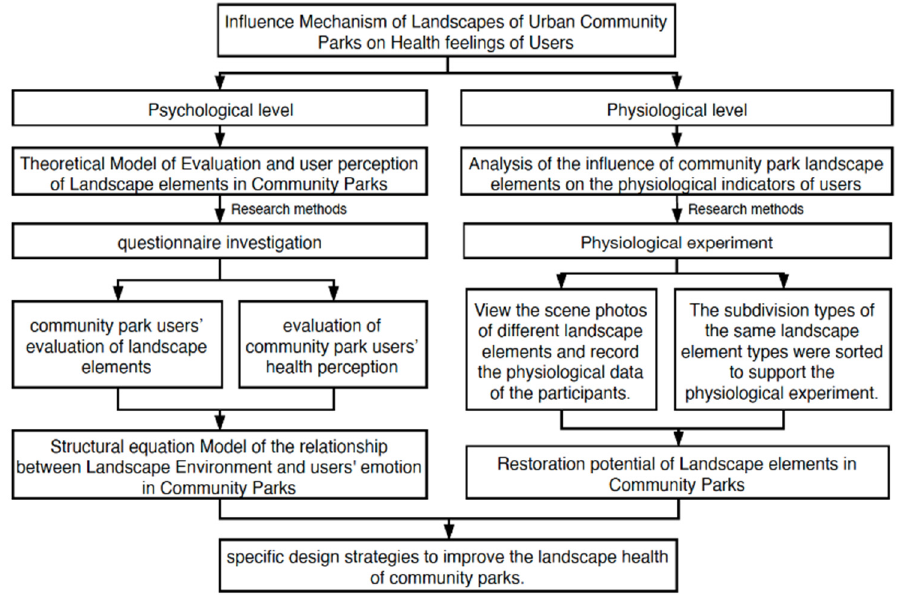
Figure 1. Schematic diagram of research methods to investigate the mechanisms underlying the interactions between the environment and health of community park users.